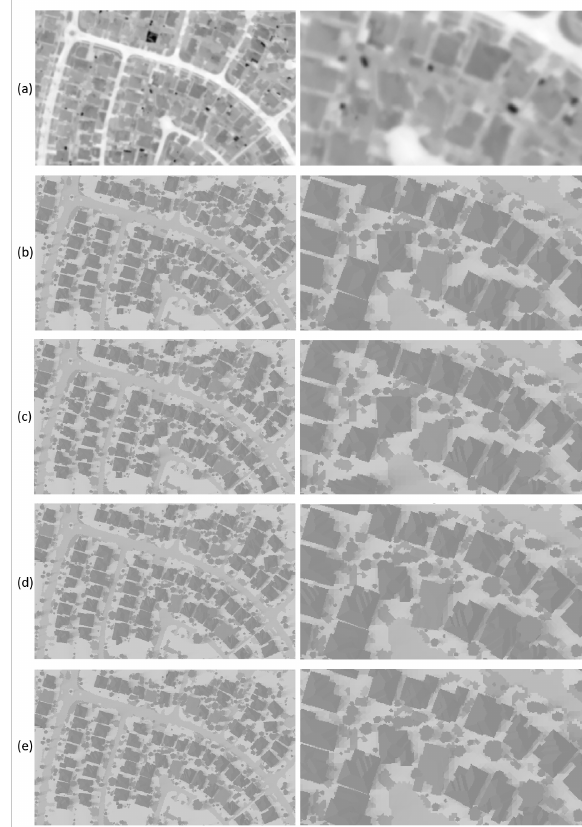
Figure 4. Measured thermal image (a) and simulated thermal images for configuration 1 (b), configuration 2 (c), configuration 3 (d) and configuration 4 (e), showing the full modelled area (left) and zoomed in (right). Color representation is white-hot